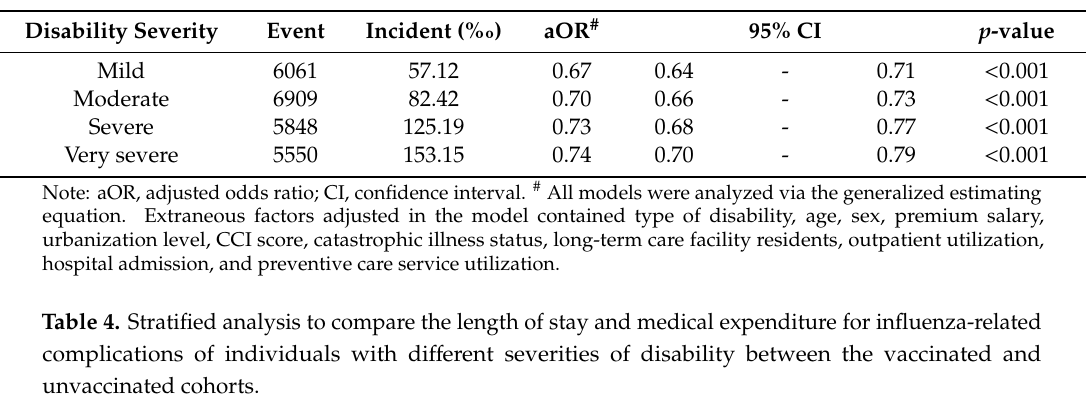
Table 4. Stratified analysis to compare the length of stay and medical expenditure for influenza-related complications of individuals with di ff erent severities of disability between the vaccinated and unvaccinated cohorts. Length of Stay Disability Severity Exp (b) Influenza and Pneumonia